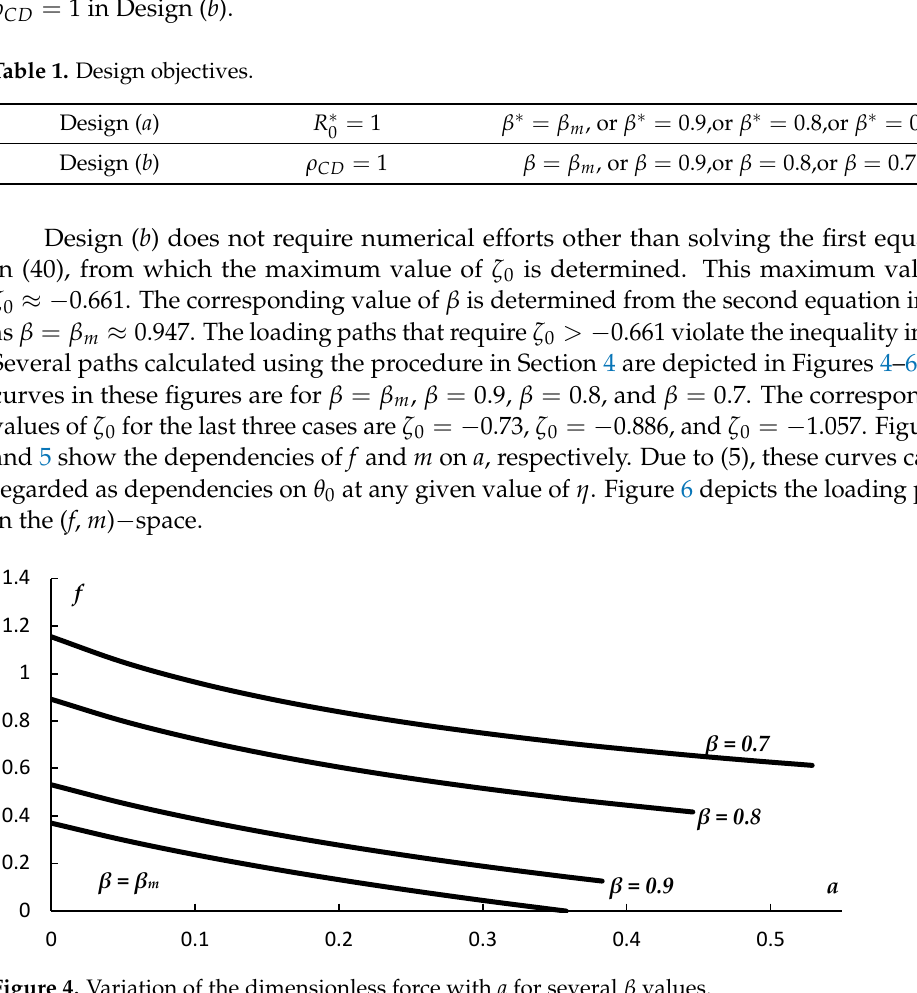
Figure 4. Variation of the dimensionless force with a for several β values.